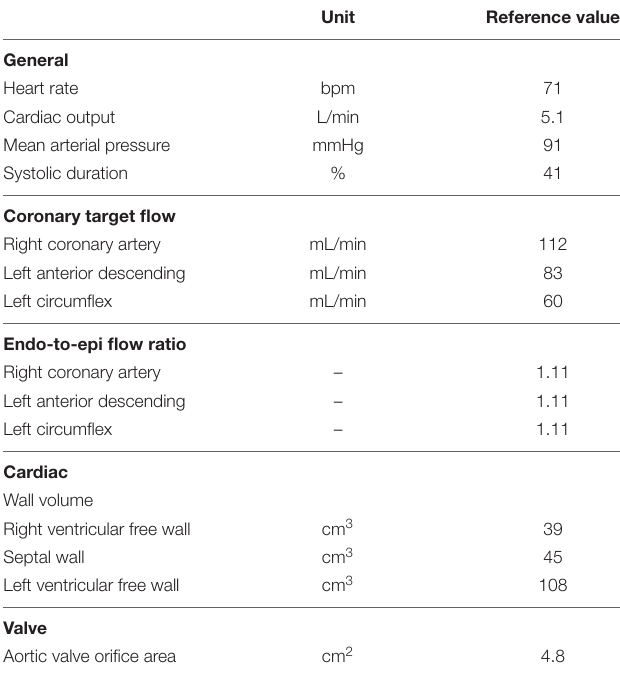
TABLE 2 | Reference input parameter